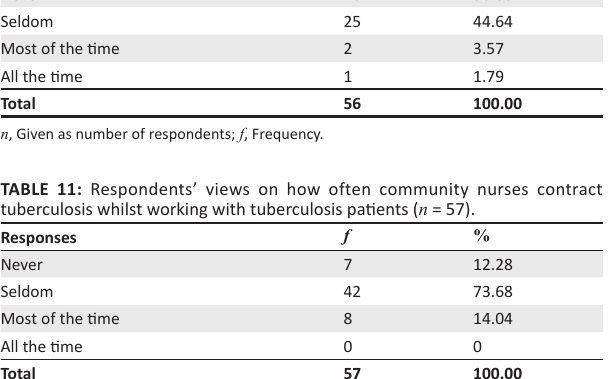
TABLE 10: Respondents’ views on how often shortages of tuberculosis medication occurred in their clinics ( n = 56). Responses